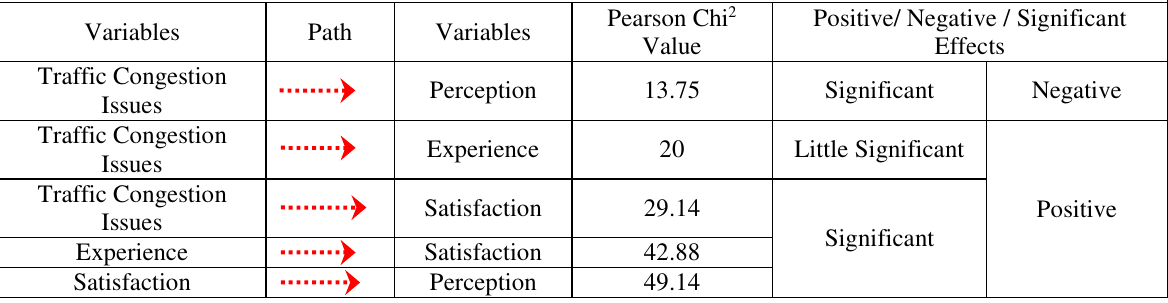
TABLE 5: RESULTS OF FIVE TESTED HYPOTHESES WITH POSITIVE / NEGATIVE / SIGNIFICANT / LITTLE SIGNIFICANT EFFECTS ON BEHAVIOURAL INTENTIONS OF CAR DRIVERS/OWNERS